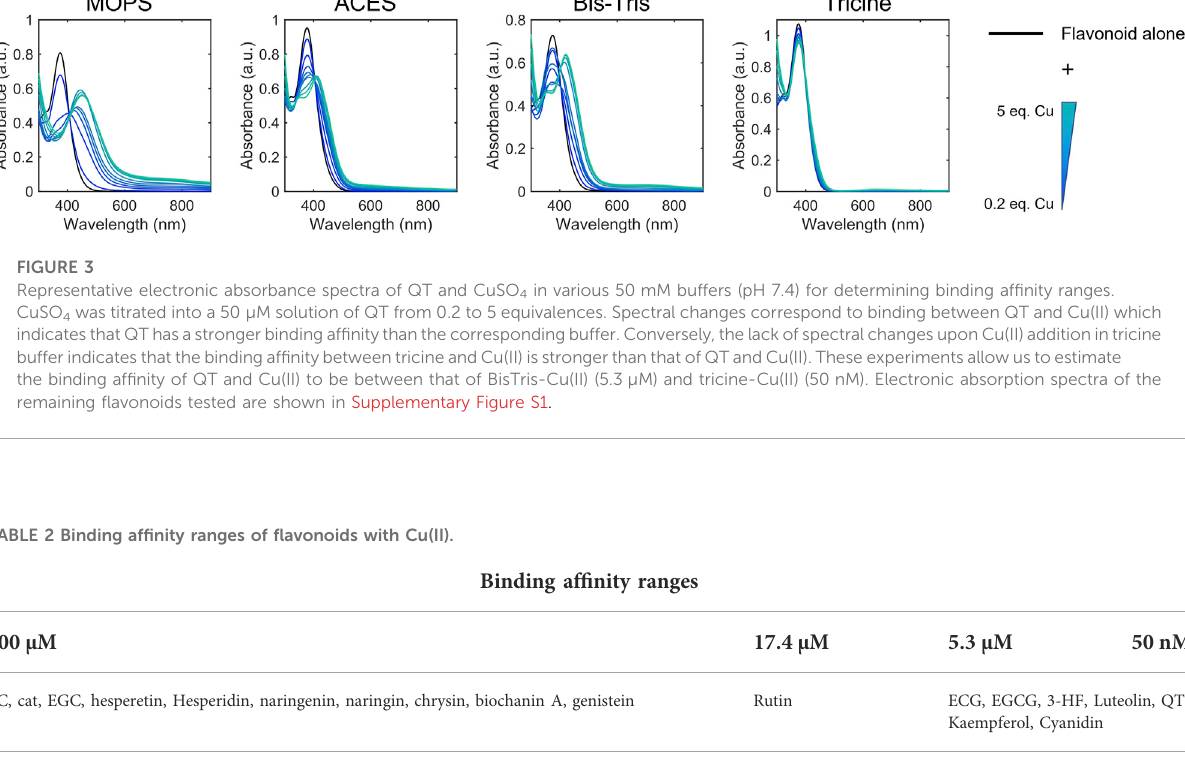
(Figure 3; Table 2). (Kandegedara and Rorabacher 1999; Atp